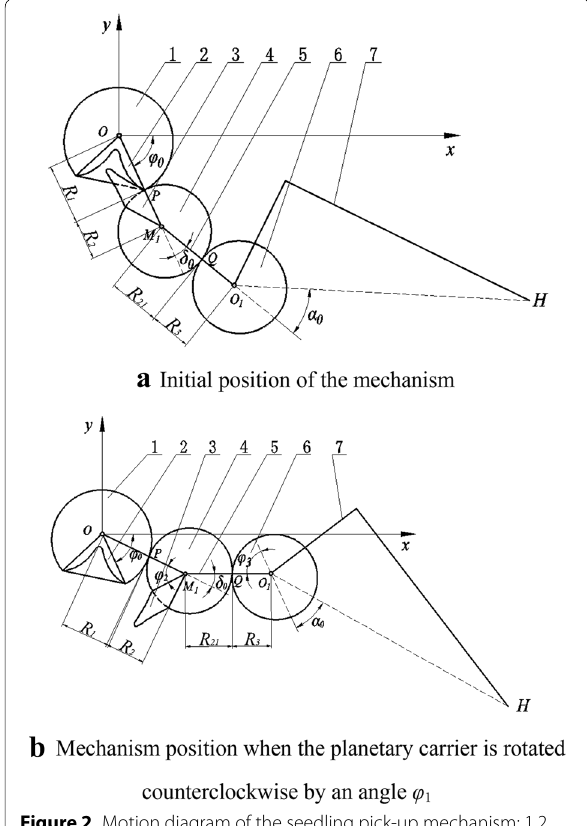
Figure 2 Motion diagram of the seedling pick-up mechanism: 1,2. Sun gear; 3,4. Middle gear; 5. Planetary carrier; 6. Planetary gear; 7. Seedling pick-up